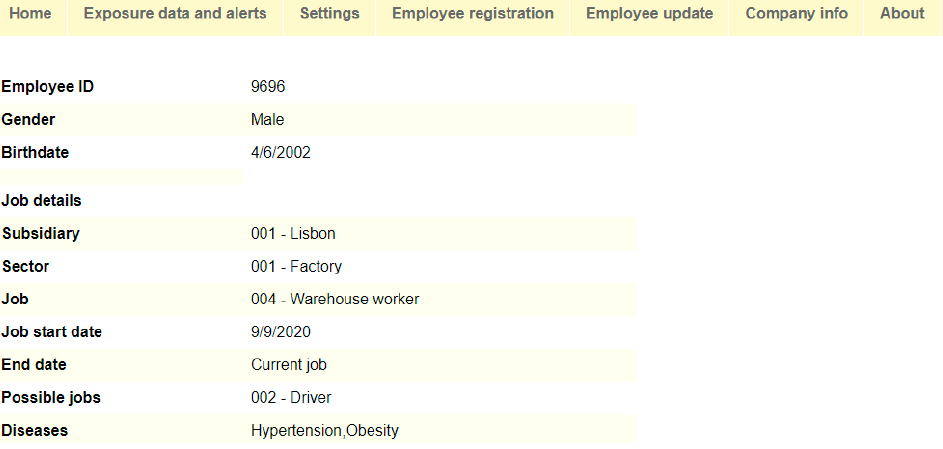
Figure 4. Example of job history with health details.